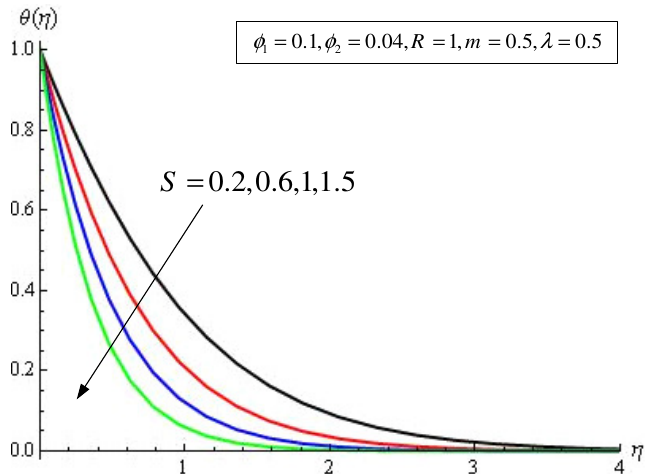
Figure 1. Velocity profiles f (cid:48) ( η ) for various values of S .